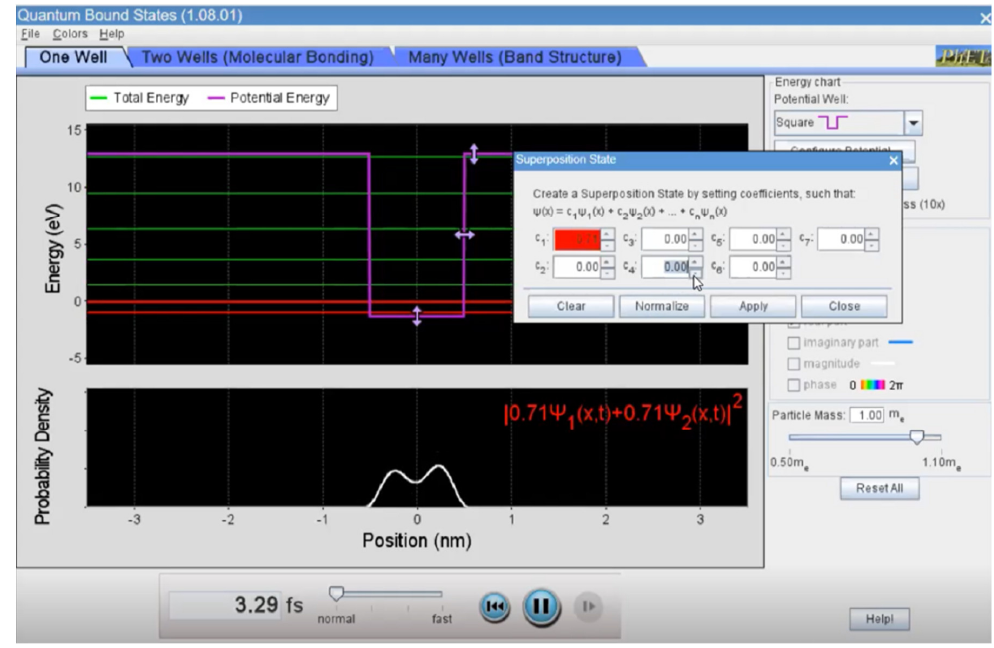
Figure A4. Examples from the specific path “The measurement paradox: Schrödinger's cat and other fantastic beasts (and where to find them)”. Before comparing system evolution governed by the Schrödinger equation and evolution in measurement, students are led to use a PhET simulation in order to elicit qualitative properties of the former.